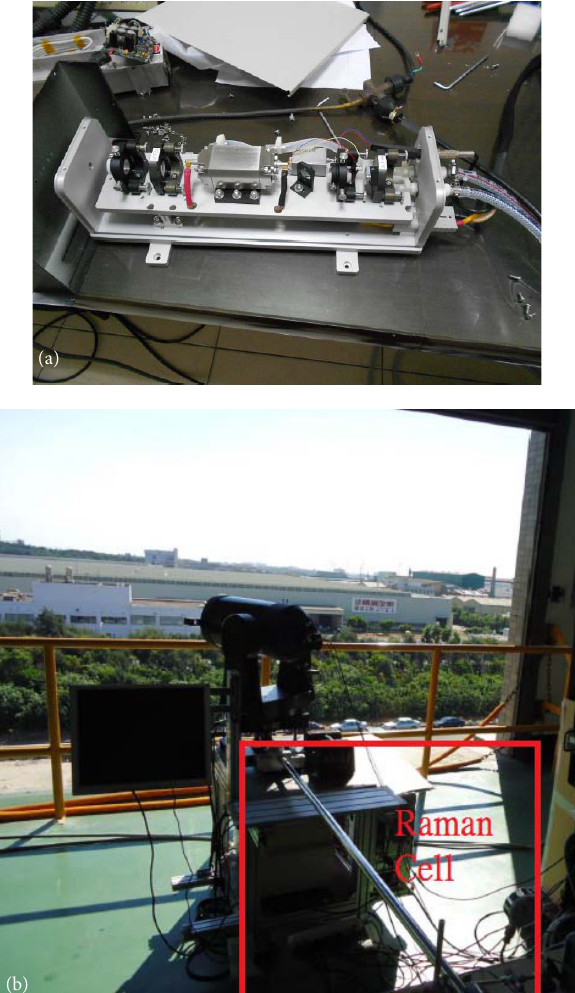
Figure 3. (a) The in-house developed laser (500mJ at 532nm). (b) Lidar system with the Raman cell (Raman